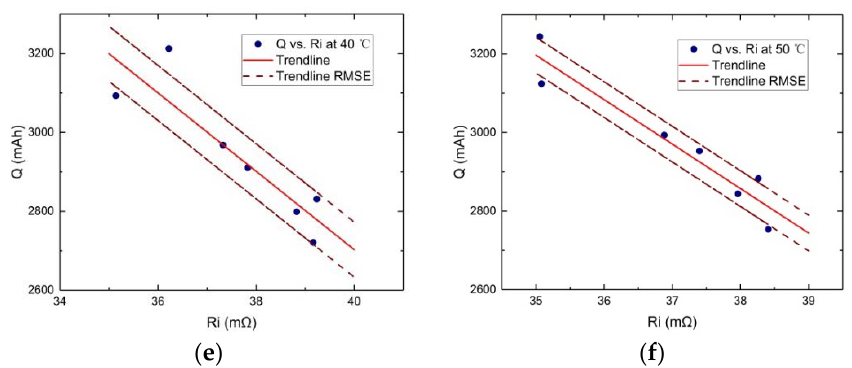
Figure 6. Linear fitting relationship between capacity and internal resistance for batteries. RMSE: Root Mean Squared Error.